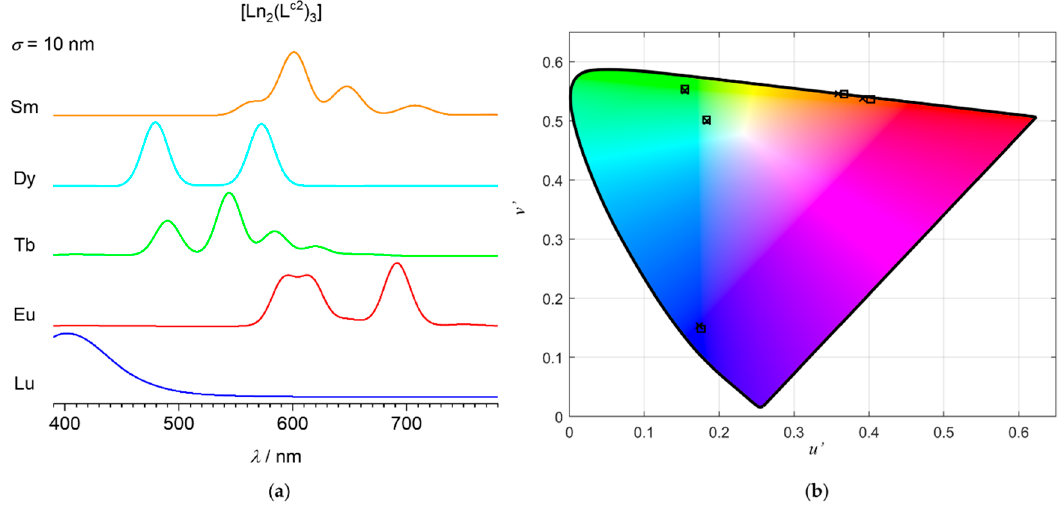
Figure 3. ( a ) Simulated relative spectral irradiances for broadened Ln spectra (Gaussian function with σ = 10 nm) and ( b ) corresponding colours (crosses) compared to the colours obtained from the original spectrum shown in Figure 1 (squares).